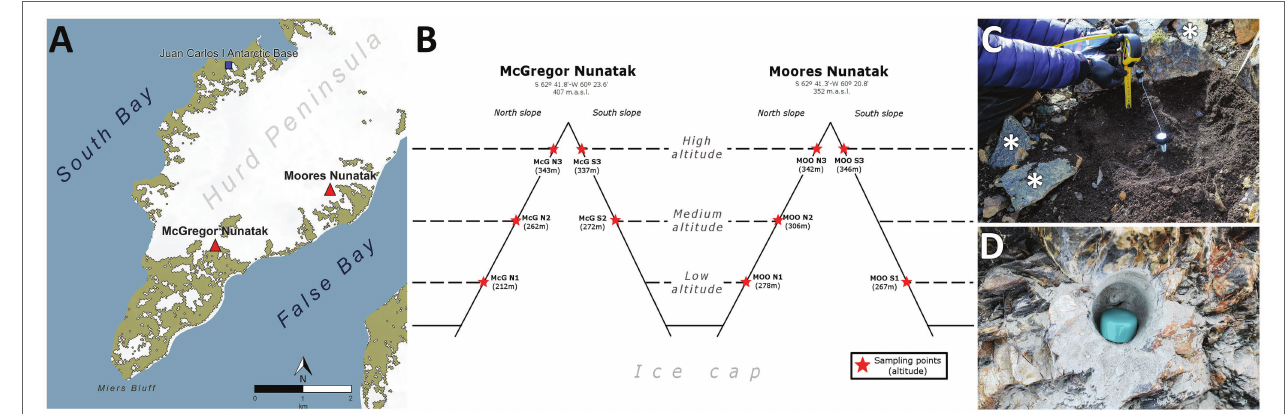
FIGURE 1 | Study and sampling location. (A) Location of sampled nunataks and Juan Carlos I Spanish Antarctic Base at Hurd Peninsula, Livingston Island (South Shetlands). (B) Sampling points distribution along Northern and Southern slopes at both McGregor and Moores nunataks. (C) Example of manual sampling of both soils and individual loose rocks (asterisk) at every sampling point. (D) Example of drilling hole for bedrock substrate sampling at every sampling